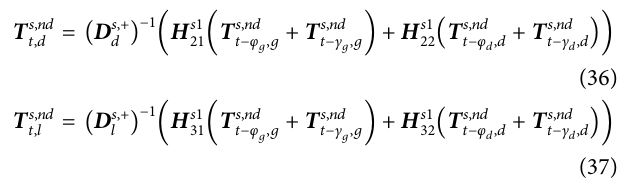
Frontiers in Energy Research |